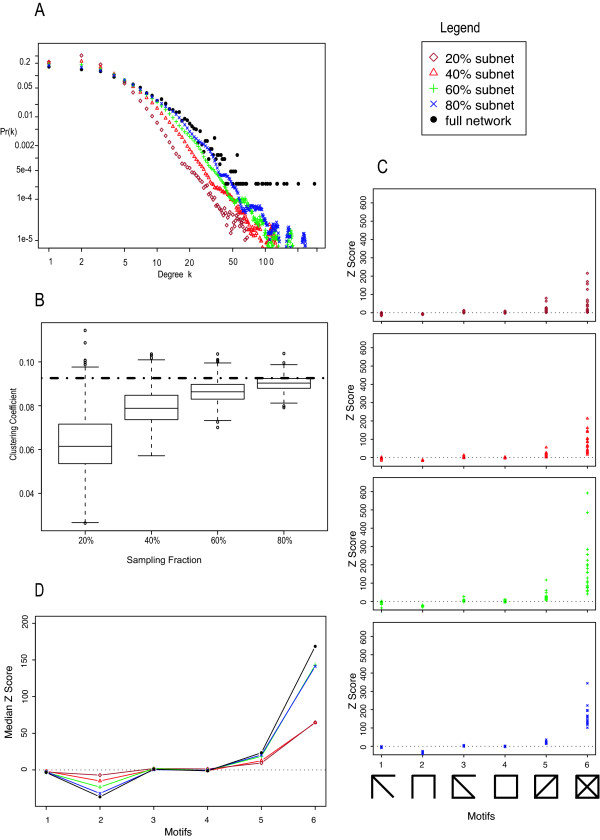
Properties of the yeast protein interaction networks under random sampling. (A) The degree distribution for the full network and the average for the subnets (averaged over the ensemble) generated by sampling 80%, 60%, 40% and 20% of the nodes in the Saccharomyces cerevisiae protein interaction network. Nodes with degree k = 0 have been dropped from the analysis, reflecting the content of interaction databases. (B) The horizontal line shows the clustering coefficient of the full network. From the boxplots it is apparent that with decreasing subnet size the clustering coefficient will tend to decrease, reflecting the increasingly sparse network with a correlated structure. (C) Z-scores for the six 4-motifs in the true network and 20 random subnets for sampling fractions p = 80%, 60%, 40% and 20%. (D) Median Z-scores for each motif in each of the subnet ensembles and the Z-score of the motif in the full network. In (C) and (D) a positive Z-score indicates that the motif is overrepresented in the true network compared with randomly rewired versions of the true network; a negative Z-score indicates under-representation.